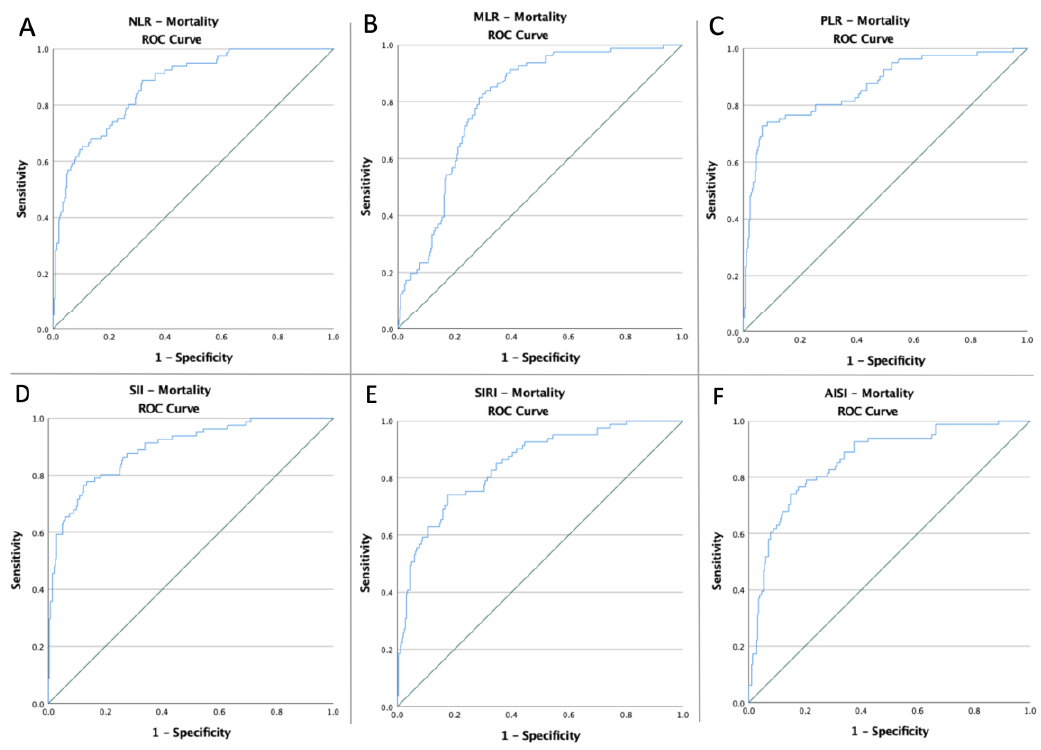
Figure 2. ROC curve analysis concerning the mortality ( A ) NLR (AUC: 0.870; p < 0.0001), ( B ) MLR (AUC: 0.800; p < 0.0001), ( C ) PLR (AUC: 0.865; p < 0.0001), ( D ) SII (AUC: 0.893; p < 0.0001), ( E ) SIRI (AUC: 0.846; p < 0.0001), and ( F ) AISI (AUC: 0.859; p < 0.0001); blue line – ROC curve; green line – diagonal line. Table 2. ROC curves, ideal cut-off value, AUC, and prediction accuracy of inflammatory indicators in terms of outcomes.